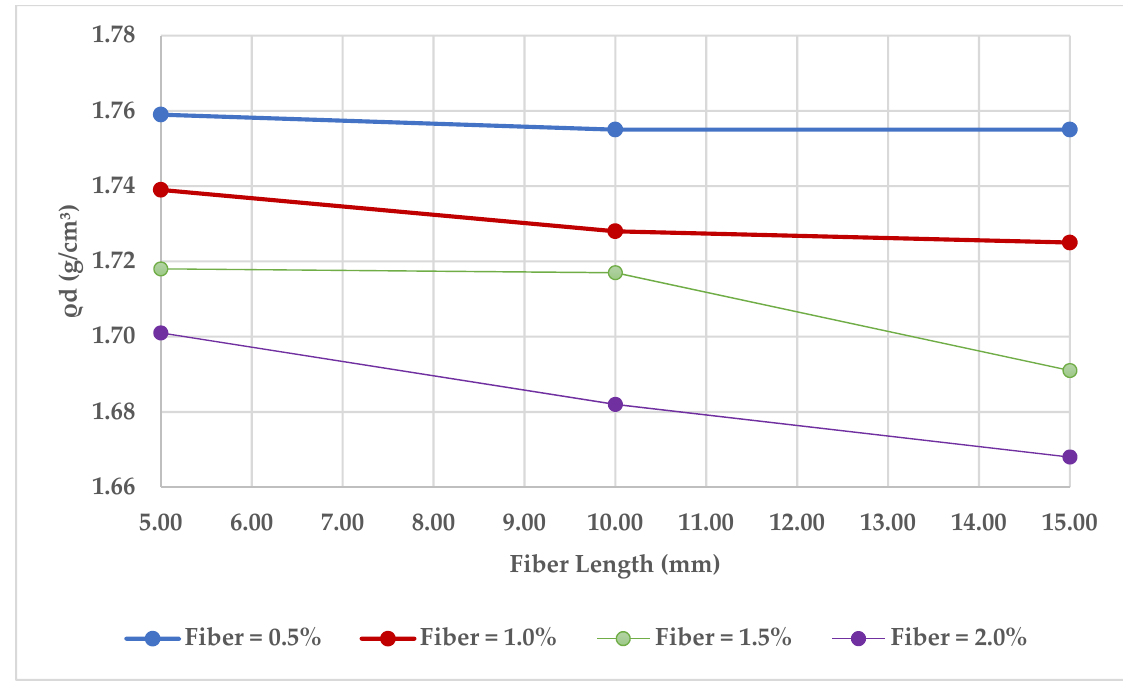
Figure 10. ρ d vs. Fiber Length. Table 6. Linear mixed model examining the effect of condition on the log10 transformed unitary deformation. The model used ID as a random effect, with control as a reference category. The esti- mation procedure was computed using REML.